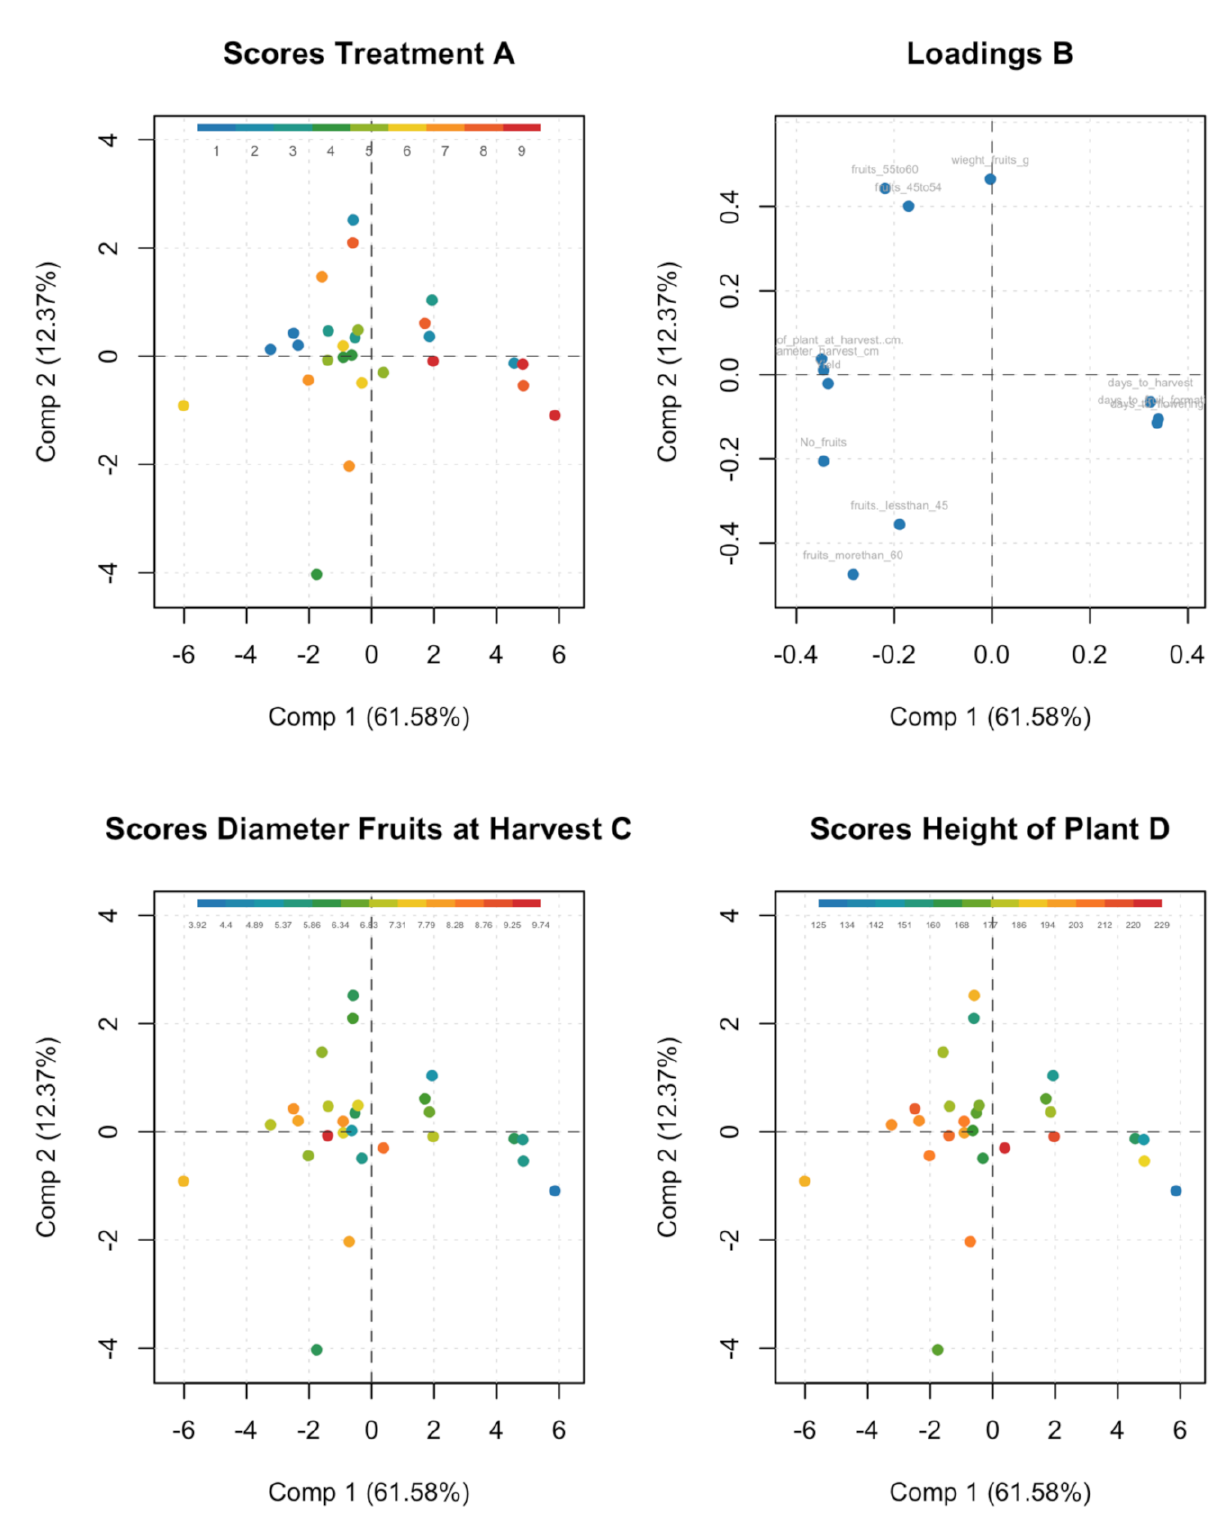
Figure 4. Principal component analysis of naranjilla fruit in the F á tima environment. Panel A is the score plot and panel B is the loading plot. Panels C and D provide a representation of the score plot colored with respect to the amount of a given variable (from low to high). Treatments 1 to 9. (1) full treatment with all macronutrients (N, P, K, Ca, Mg, and S), (2) a full treatment without nitrogen ( − N), (3) a full treatment without phosphorus ( − P), (4) a full treatment without potassium ( − K), (5) a full treatment without calcium ( − Ca), (6) a full treatment without magnesium ( − Mg), (7) a full treatment without sulfur ( − S), (8) no nutrients applied plus lime (Control +lime), and (9) no nutrients applied without lime (Control